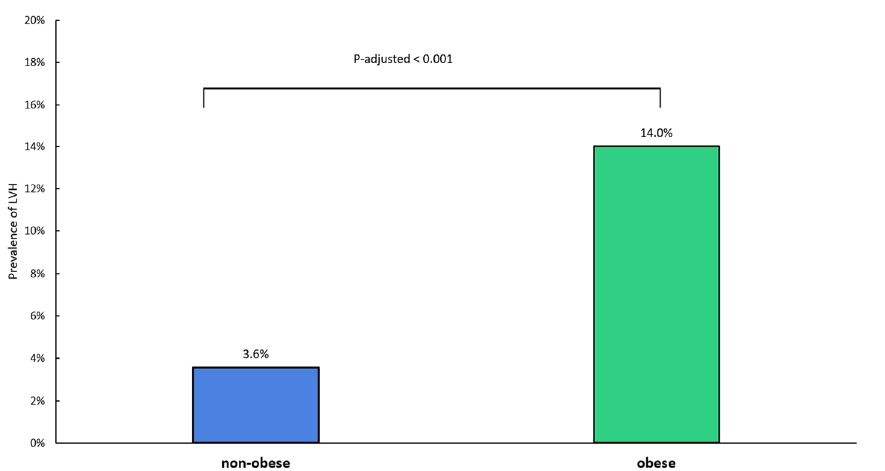
Figure 3. Bar graph illustrating prevalence of left ventricular hypertrophy (LVH) in obese and non-obese